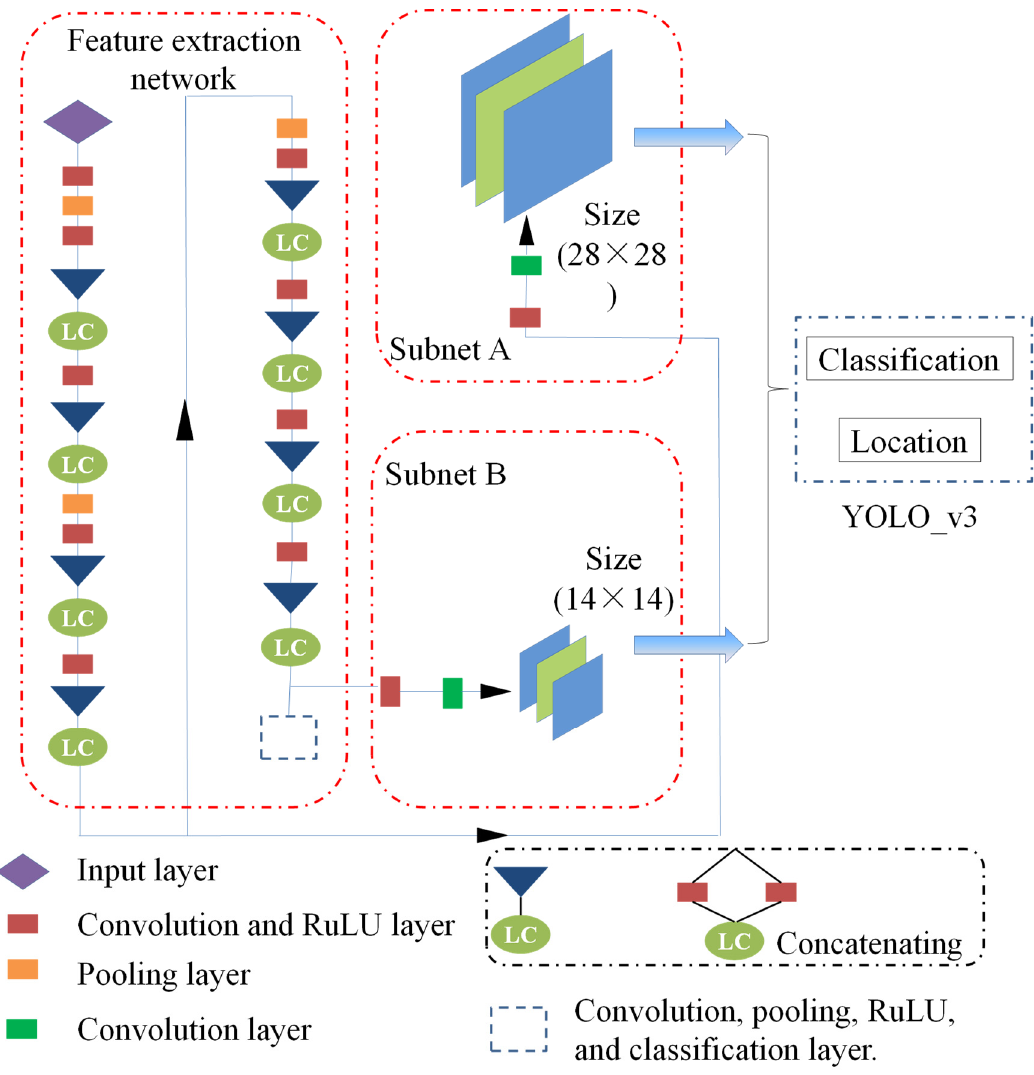
Figure 5. The YOLOv3 architecture.